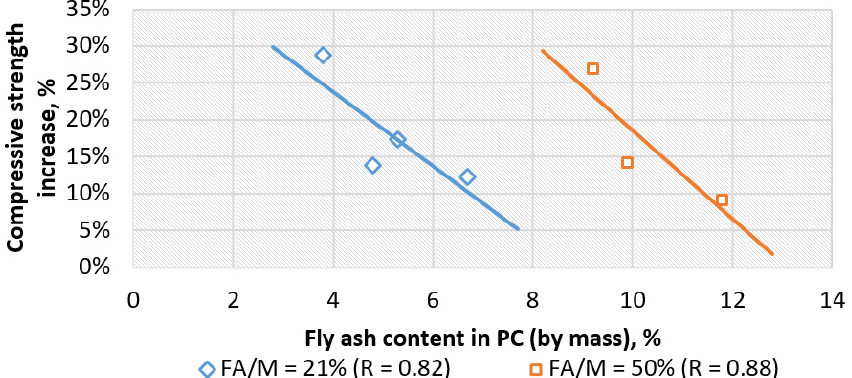
Figure 7. The increase in compressive strength of vinyl-ester concretes with various content of fly ash of lignite FBC registered after 9.5 years in relation to fly ash mass content; the tendencies (statistical significance level α = 0.05) were determined separately for concretes where 21% of the quartz microfiller was substituted by fly ash (FA/M = 21%) and concretes where half of the quartz microfiller was substituted by fly ash (FA/M = 50%).